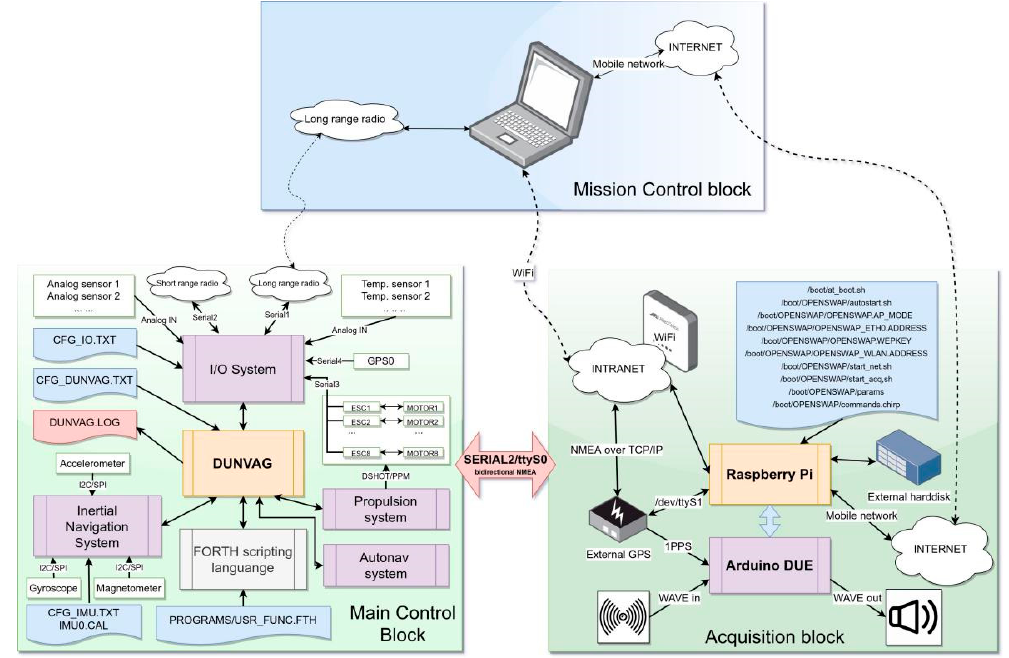
Figure 5. Block diagram showing OpenSWAP hardware/software architecture.